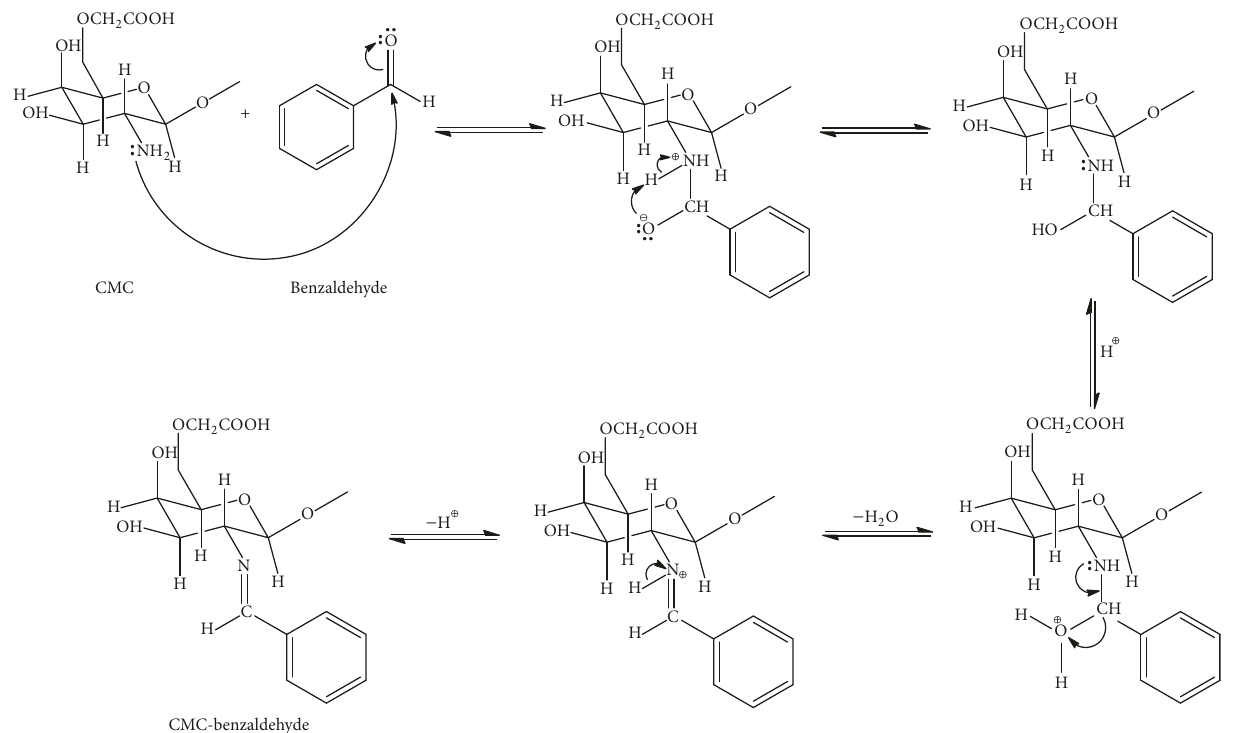
Figure 4: Reaction mechanism of CMC-benzaldehyde formation.